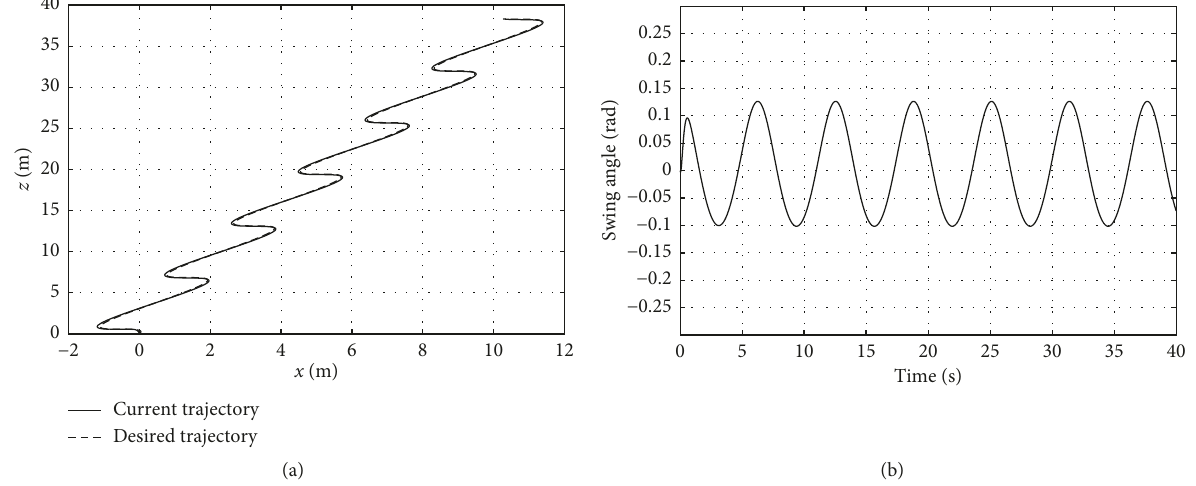
Figure 7: Trajectory of the quadrotor in X-Z plane and pendulum swing angle.